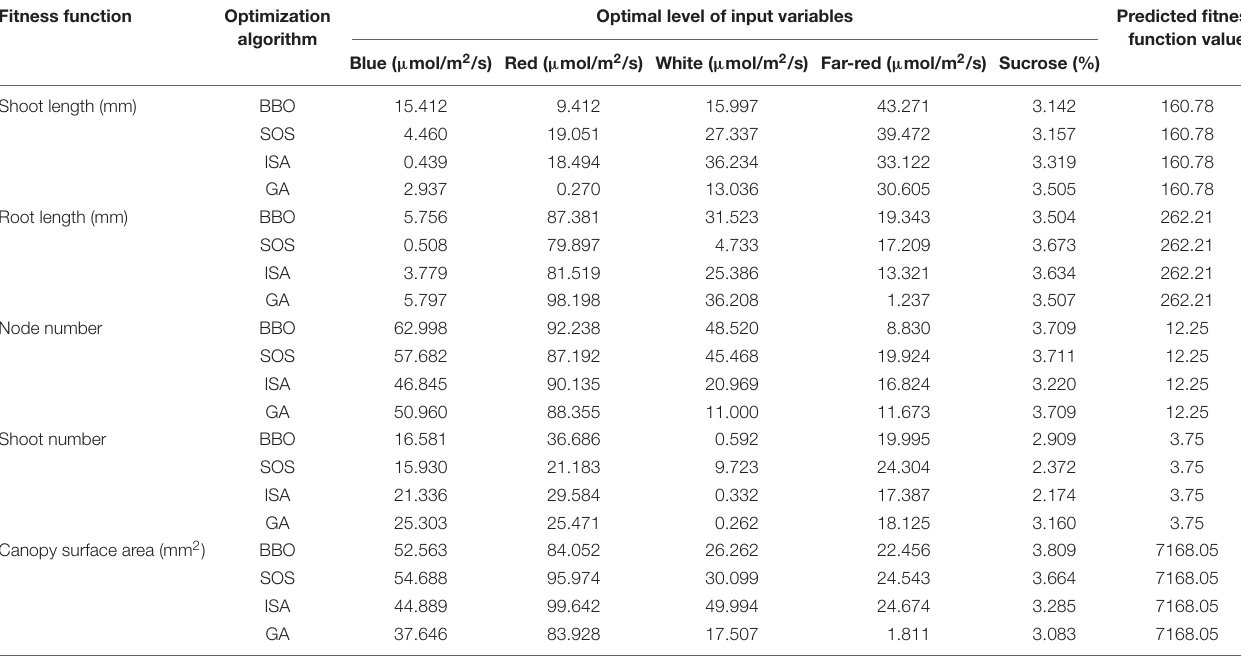
VSR, variable sensitivity ratio. TABLE 4 | The results of optimization process via different evolutionary optimization algorithms (BBO, SOS, ISA, and GA). Fitness function Optimization